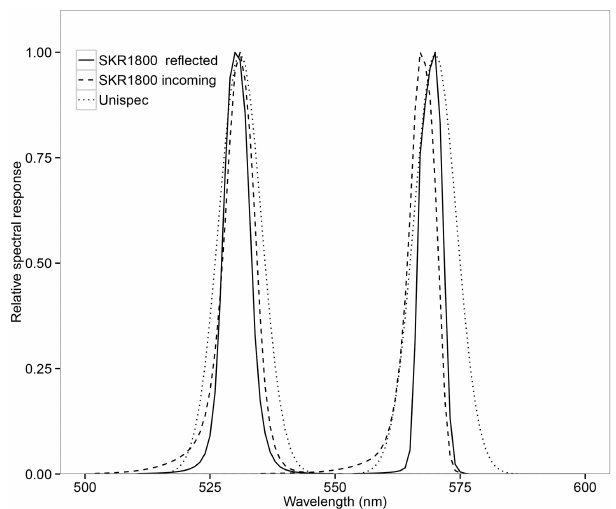
Figure 1. Spectral response curves for the UniSpec instruments and the upward- (incoming) and downward-looking (reflected) SKR 1800 sensor